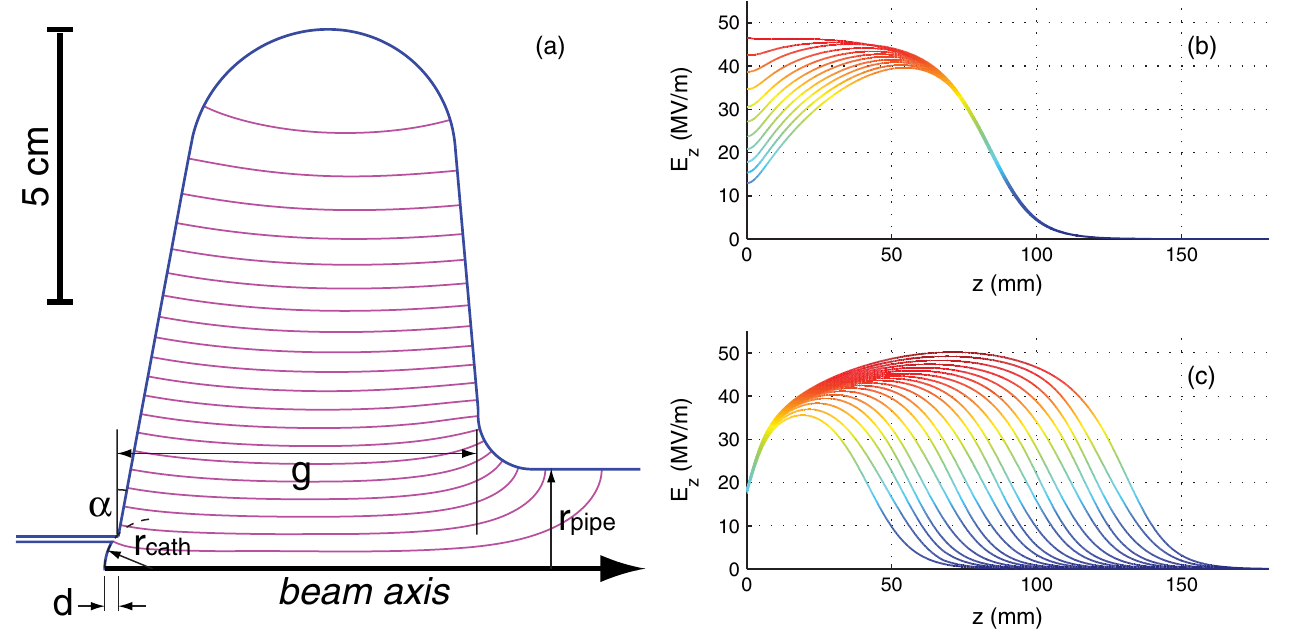
FIG. 2. (a) The parameters of the SRF cavity geometry, modeled after the 1.3 GHz TESLA design. The radius r cath and recess d of the photocathode, the angle (cid:2) of the leftmost cavity wall, the gap g between photocathode and exit pipe, and the exit pipe radius r pipe are varied, with the equatorial cavity radius left as the free parameter for frequency tuning. Here, lines of constant azimuthal magnetic field are shown. (b) The effect of varying the angle (cid:2) (from 0 to 25 (cid:4) ) on the axial electric field for fixed g ¼ 75 mm , r pipe ¼ 1 : 83 cm , d ¼ 0 , and 1 =r cath ¼ 0 . (c) The effect of varying the gap g (from 15 to 105 mm) for fixed (cid:2) ¼ 10 : 5 (cid:4) , d ¼ 1 : 67 mm , r cath ¼ 15 mm , and r pipe ¼ 1 : 83 cm .